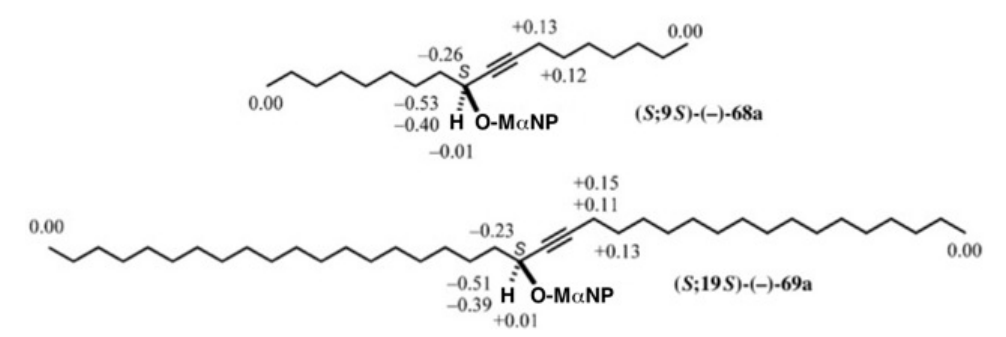
Figure 48. 1 H-NMR ∆ δ values in ppm and ACs of the first-eluted M α NP esters 68a and 69a . Reprinted with permission from [62].